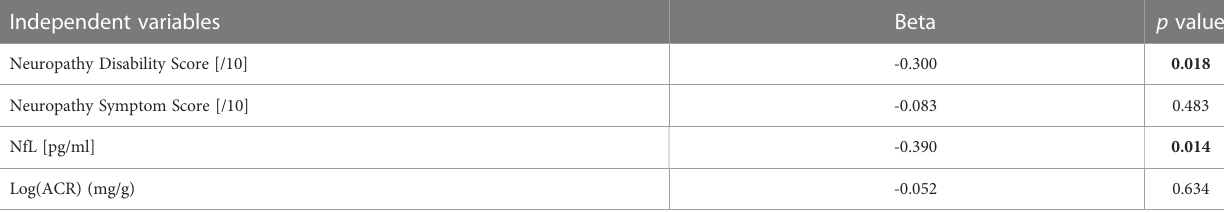
TABLE 5 Linear regression analysis for FA (dependent variable) of the sciatic nerve in all participants. Independent